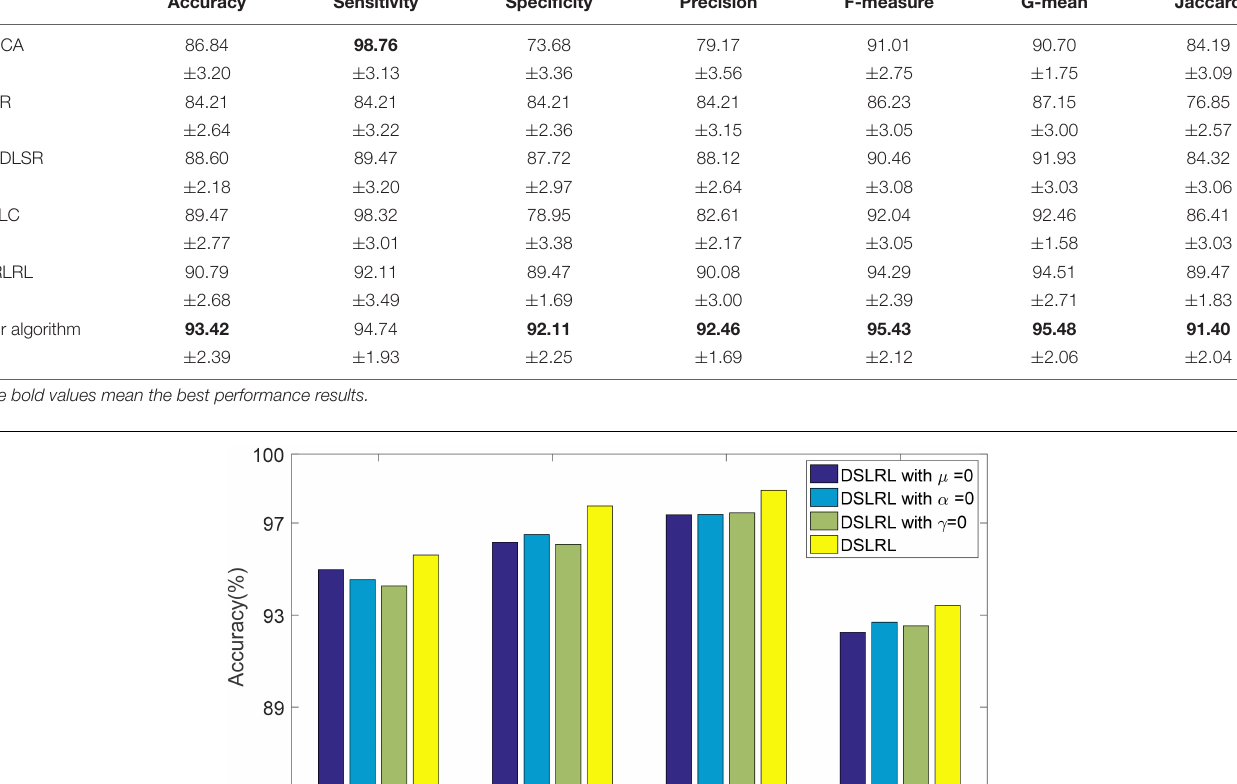
TABLE 4 | Classification results of the comparison algorithms in HC and MCI dataset.